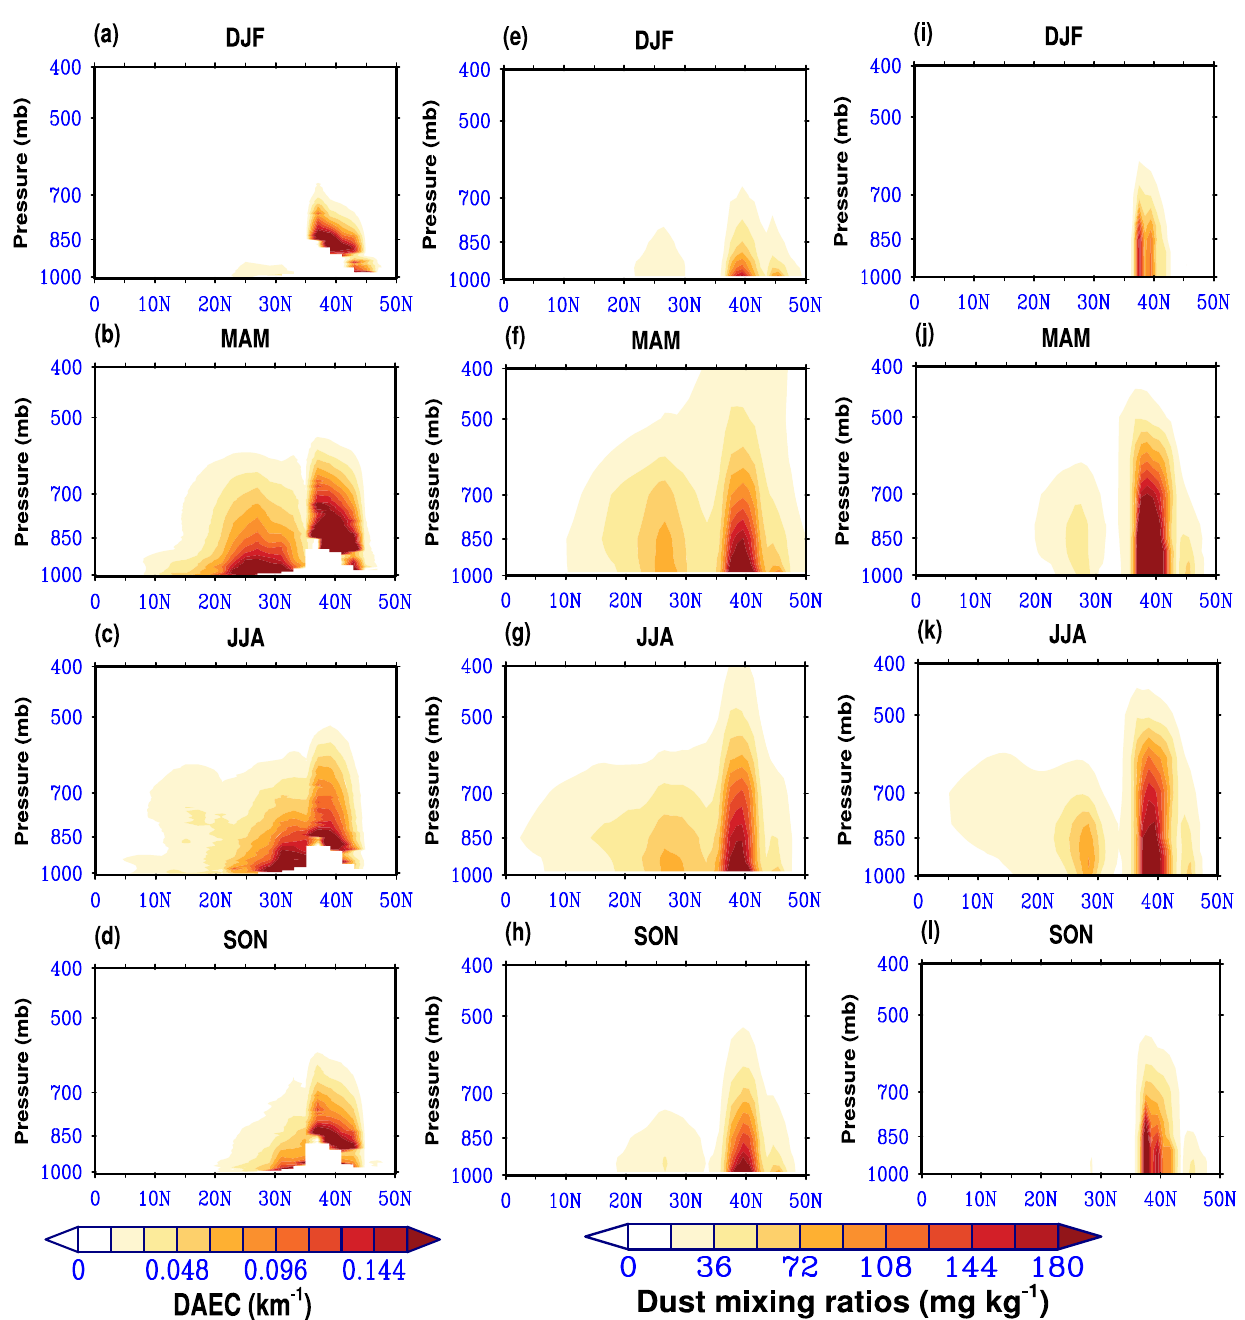
Fig. 6 Zonal climatology of dust aerosol distribution over Indian Subcontinent. Seasonal zonal climatology of dust aerosol extinction from CALIOP ( a – d ), and dust mixing ratios from MERRA-2 ( e – h ) and CAMS ( i – l ) over the Indian Subcontinent (zonally averaged between 73°E and 90°E) during the period 2007 – dust is visible from 18 to 10°N, mostly facilitated by the low-level northerlies from the higher latitudes (Supplementary Fig. 2f). The dust load north of 35°N is contributed by the Taklimakan desert, where the dust emissions are maximum during spring 61 . The depth of the dust layer between 20 and 30°N reduces during summer (Fig. 6c) owing to the wet scavenging favored by the onset of the Indian summer monsoon. A weekly intense mid- tropospheric dust transport is also noticeable above the 850 hPa level stretched between 10 and 20°N. Dust from the AP is transported to the IS between the top of the boundary layer and